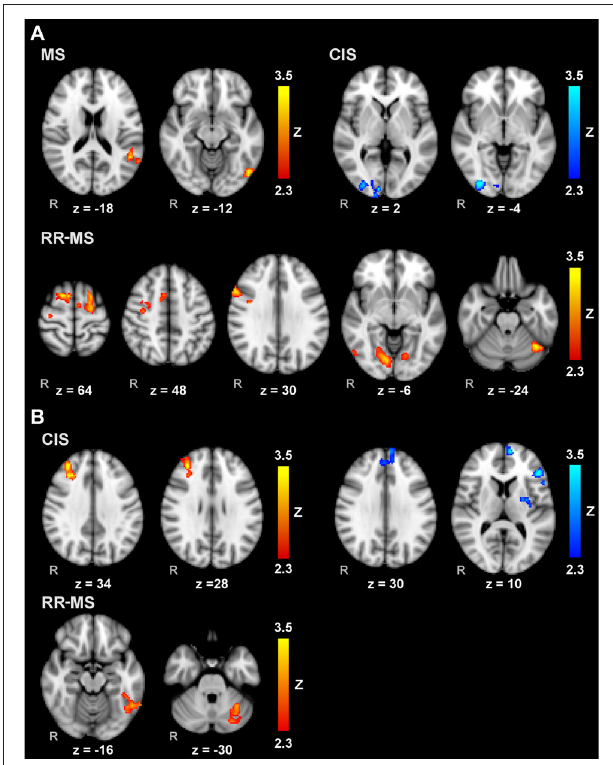
FIGURE 3 | Voxelwise correlations of brain activity during MM with the right (A) and left (B) hands and the corresponding index of performance (IP) scores for the whole group of MS patients, and separately for CIS and RR-MS patients. Results are cluster corrected for multiple comparisons ( Z > 2.3; P < 0.05) and are shown in red-yellow for positive correlations, indicating worse performance associated with more activation, and light-dark blue for negative correlations, indicating where better performance is associated with more activation, overlaid on the MNI